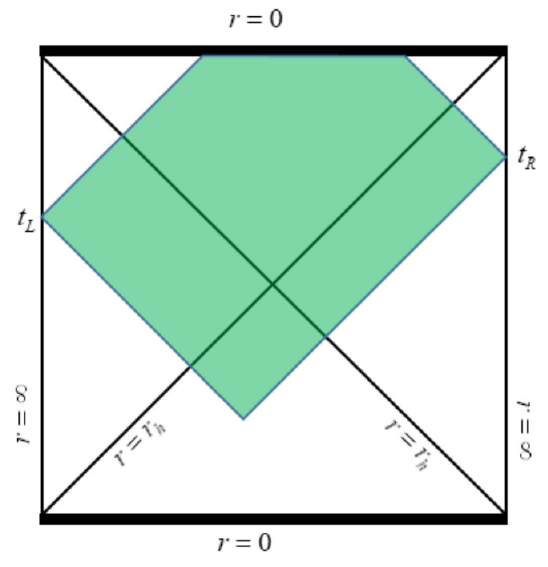
Figure 1 . The Wheeler-DeWitt patch of a Schwarzschild black hole. The upper part of the patch runs into a